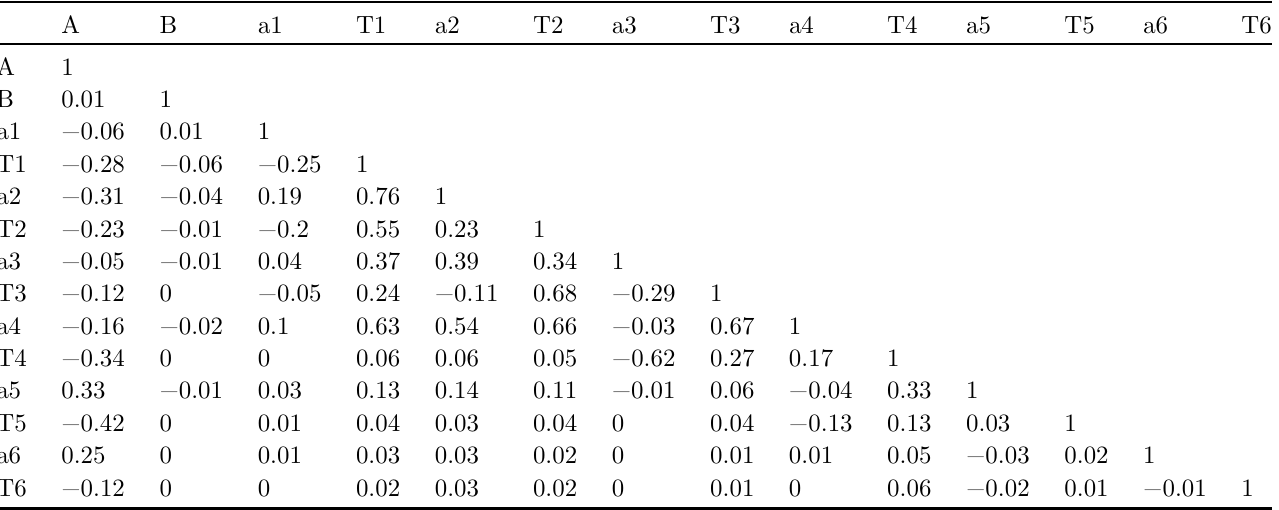
Table A6. Correlation matrix obtained using all free